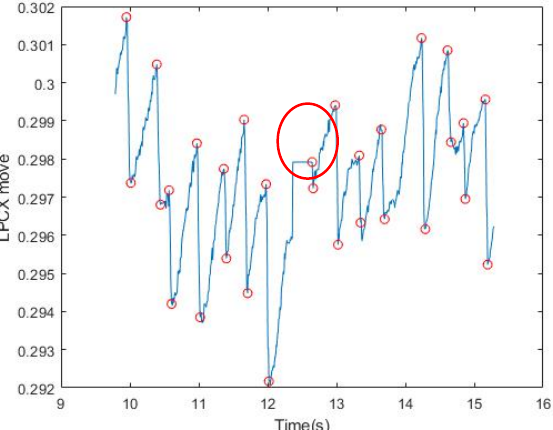
Figure 13. The red circle indicates a signal of the dull eye and that the FP determination has not been filtered.